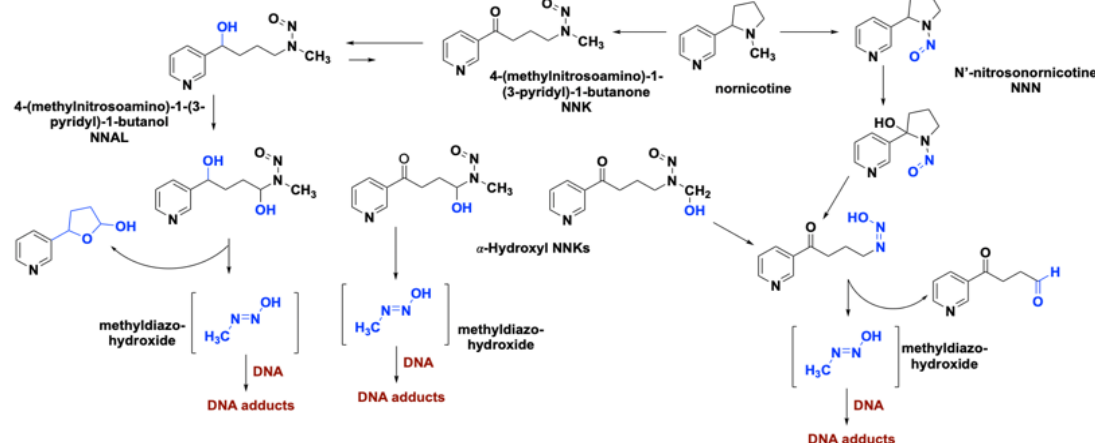
Figure 3. Role of nicotine-derived metabolites in the formation of DNA adducts.